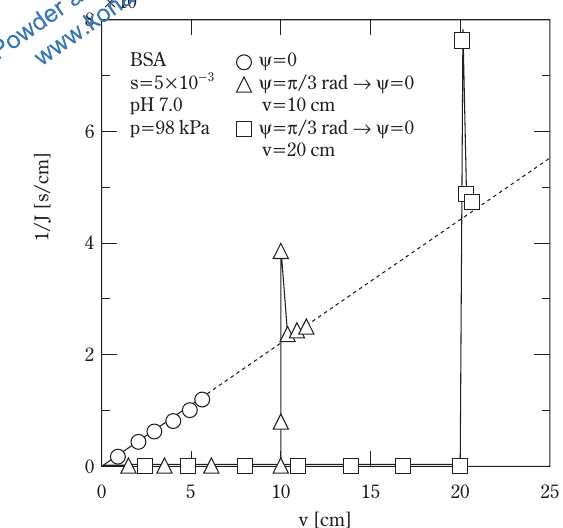
Fig. 13 Relation between reciprocal filtration rate and filtrate vol- ume per unit membrane area in various filtration